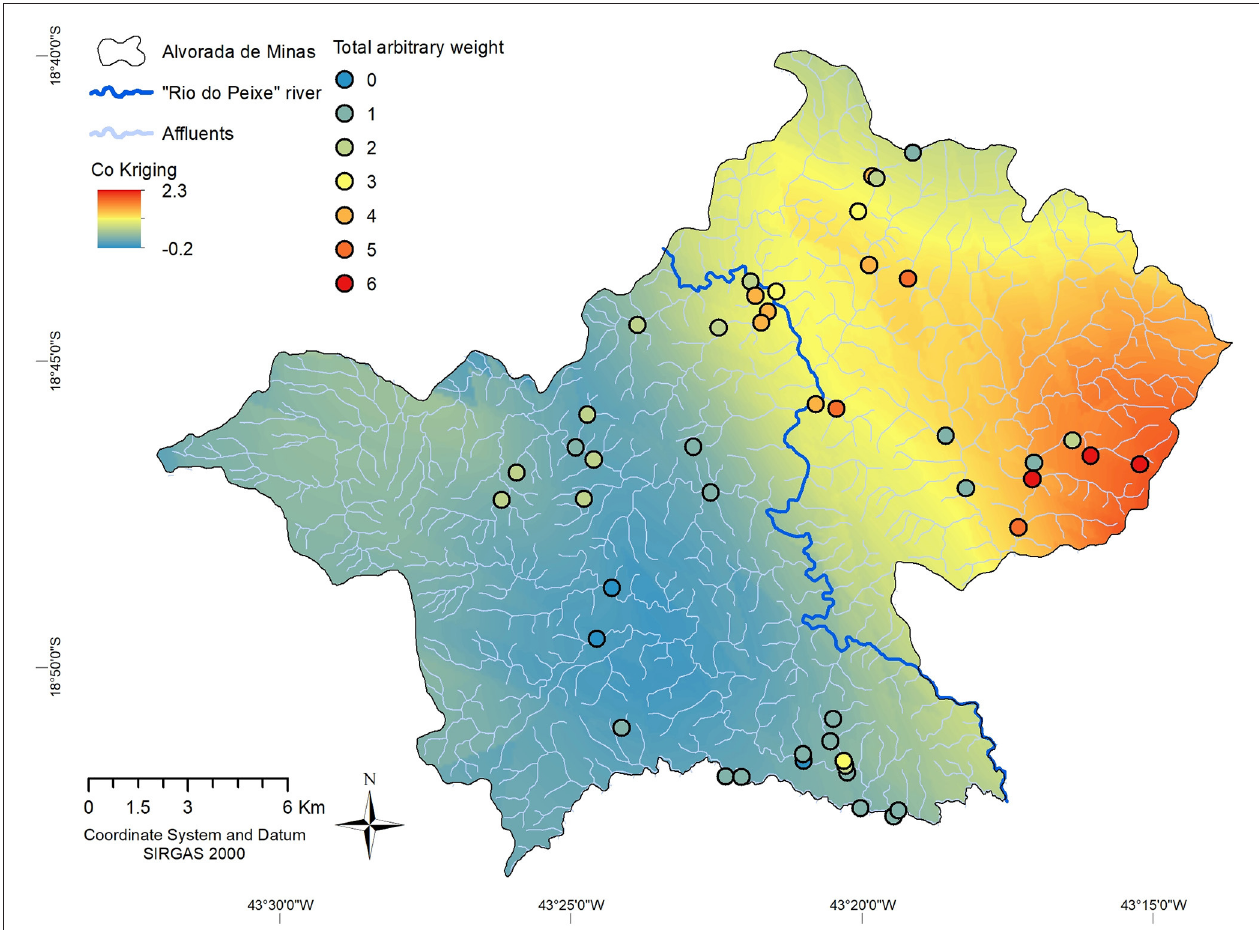
FIGURE 6 | Risk map for transmission of schistosomiasis, estimated by Cokriging with total arbitrary weight of environmental and human epidemiological data, in the Municipality of Alvorada de Minas, Minas Gerais, Brazil. Relative risk is indicated by a graduated color map, with red areas corresponding to high risk and dark blue areas with absent risk of